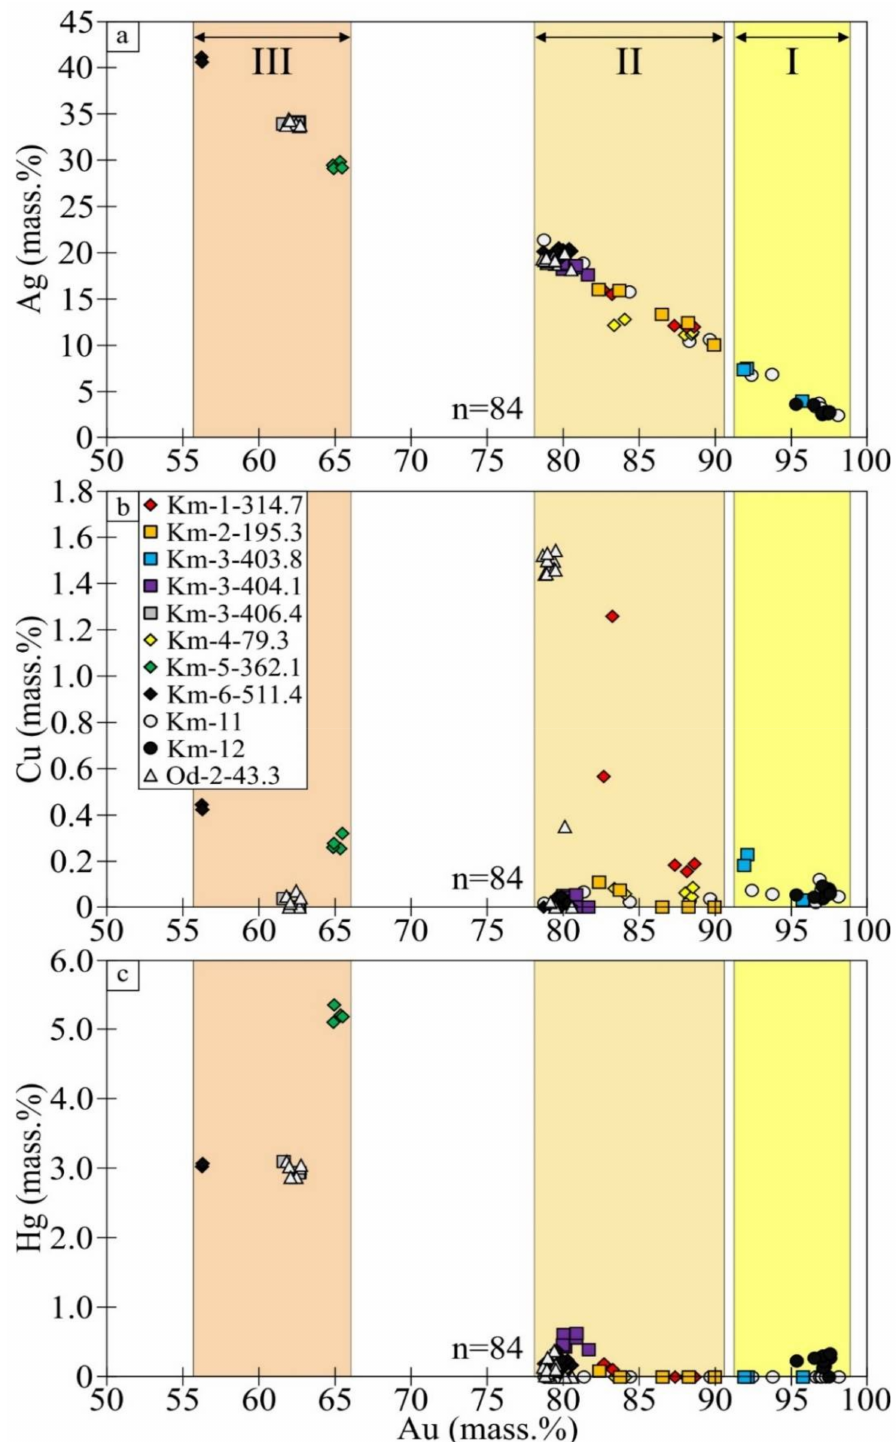
Figure 16. Variations in composition of native gold. ( a ) Au versus Ag contents; ( b ) Au versus Cu contents; ( c ) Au versus Hg contents. Highlighted groups of native gold are shown in Roman numerals (by chemical